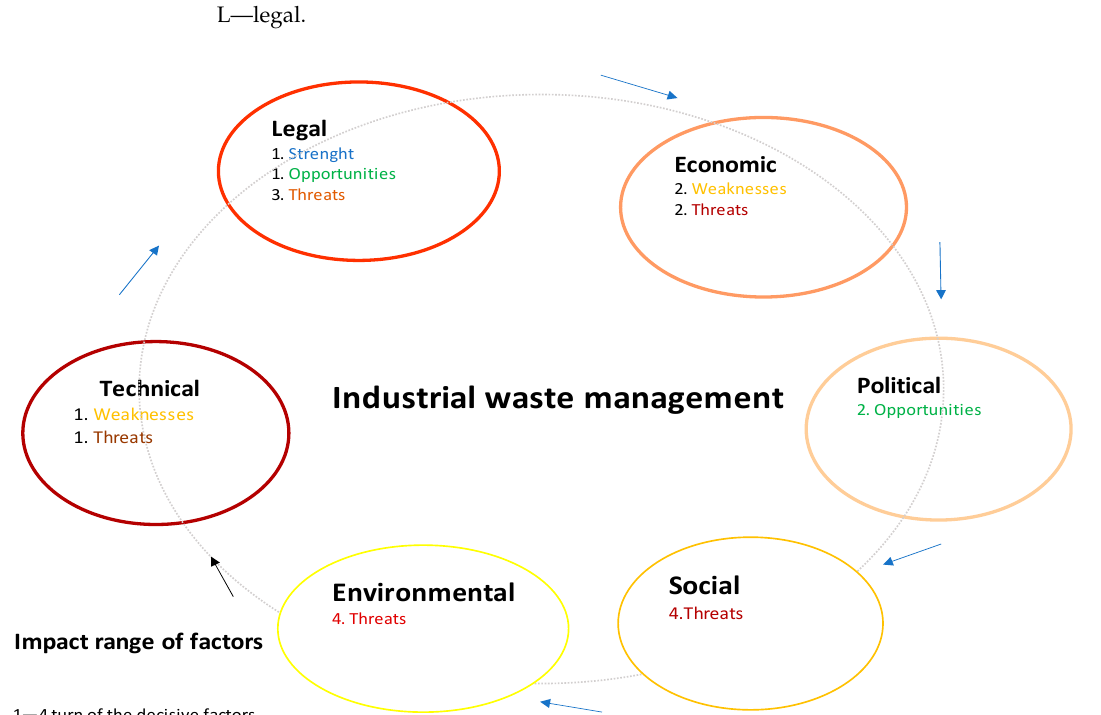
Figure 3. The rank of key and decisive factors influencing the industrial waste management.